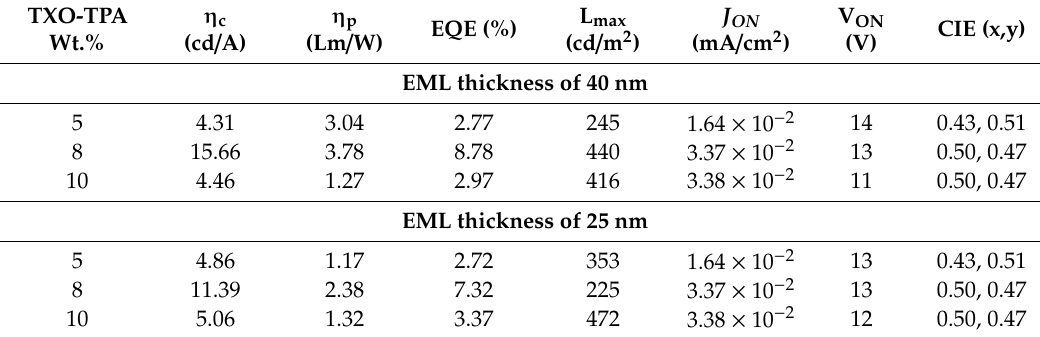
Summary of results obtained for device with structure ITO / PEDOT:PSS (40 nm)